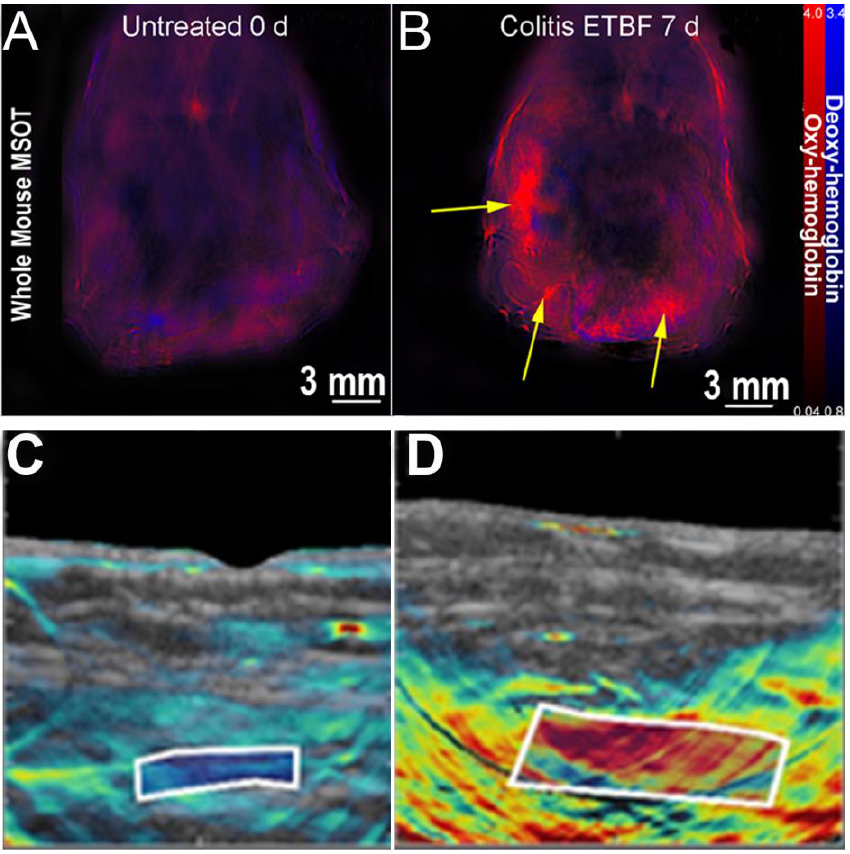
Figure 2. MSOT can visualize colitis ( A , B ) and Crohn’s disease ( C , D ) by utilizing differential levels of oxy- and deoxyhemoglobin. ( A ) Control murine model with no detectable areas of colitis. ( B ) Murine model treated with enterotoxigenic Bacteroides fragilis, resulting in visually concentrated areas of colitis (yellow arrows). ( C ) Intestinal wall of a patient in remission from Crohn’s disease, showing previous inflammation seen as deoxyhemoglobin in the white box. ( D ) Intestinal wall of a patient with active Crohn’s disease, showing inflammation seen as oxy-hemoglobin in the white box. Panels A and B are adapted with permission from [47]. Panels C and D adapted with permission from [86].